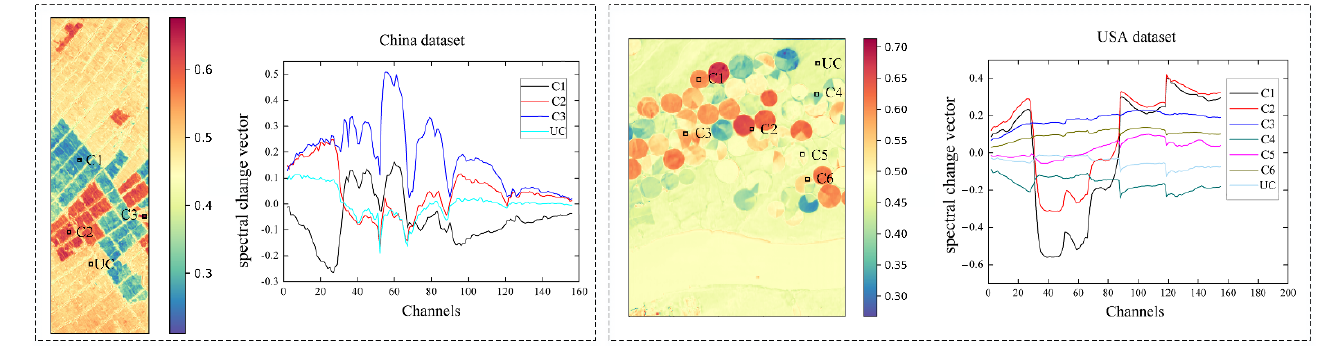
Figure 6. The heatmap of DI in the 14th band and multiple SCVs from specified pixels.